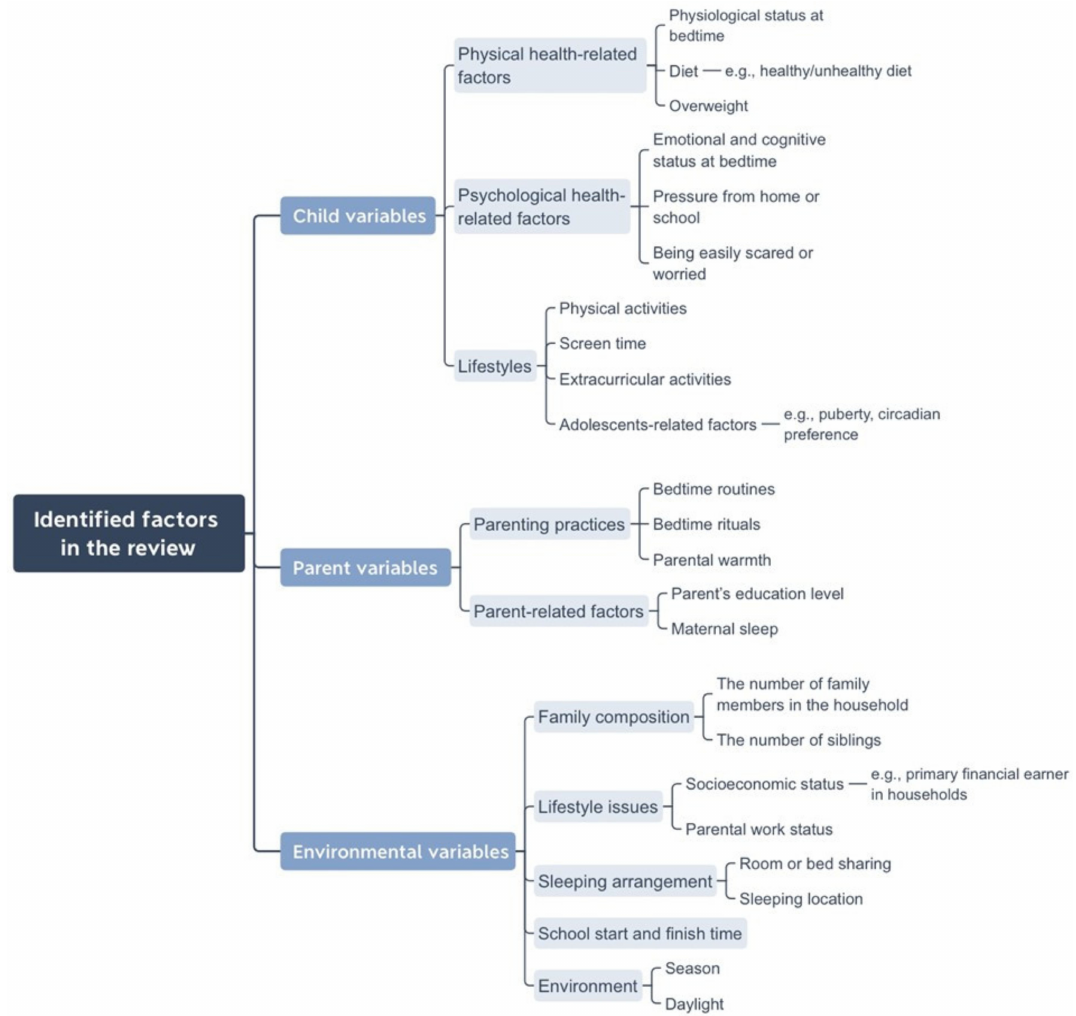
Figure 2. Parent, child and environmental factors identified in the review